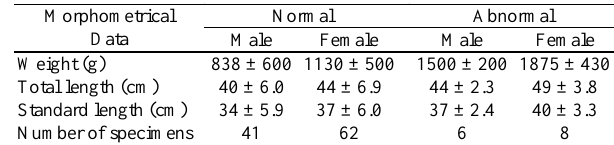
Table 1. Morphometrical data (mean ± sd) on piaparas ( Leporinus obtusidens ) with normal and abnormal